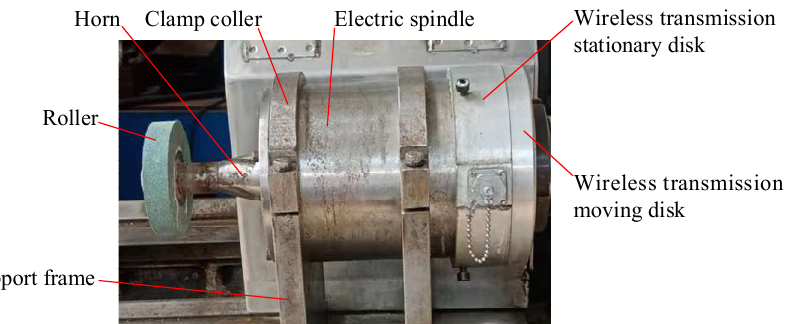
Figure 8. Physical object of the on-machine dressing device of the conductive grinding wheel after adding the ultrasonic vibration system.